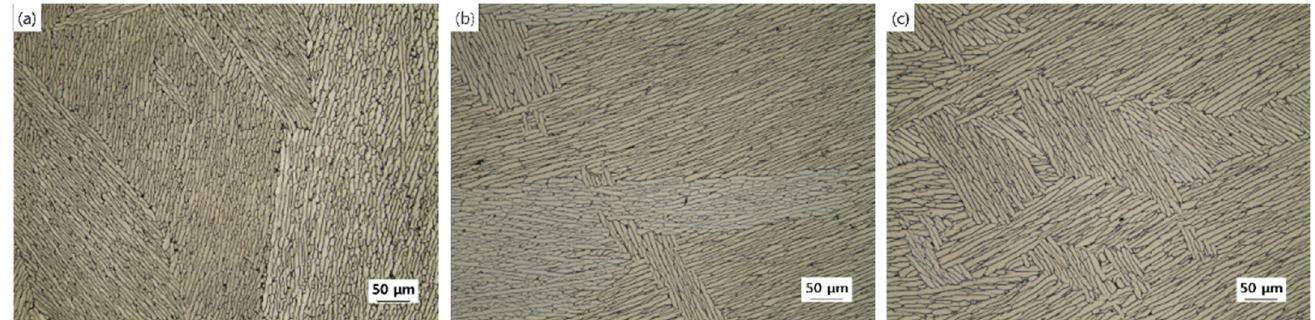
Figure 2. Optical micrographs of the as ‐ received Ti ‐ 6Al ‐ 4V alloy; ( a ) XY Plane, ( b ) YZ Plane, ( c ) XZ Plane.